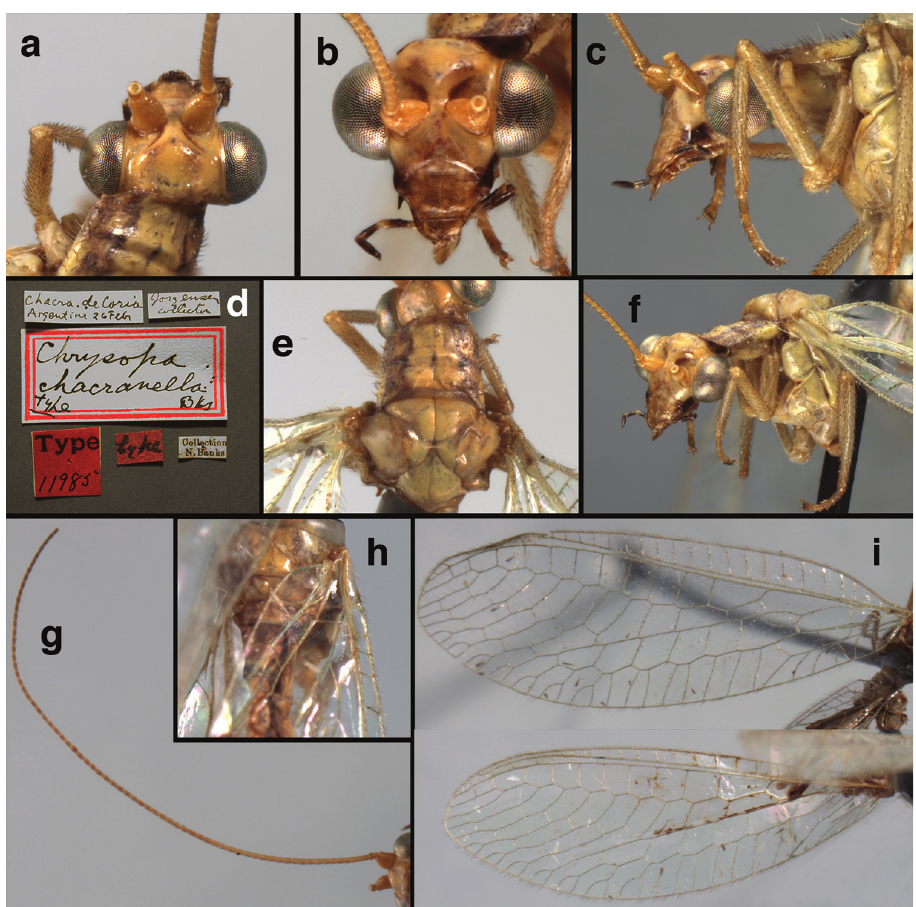
Figure 107. Chrysopa chacranella Banks: Features, ( a ) head, dorsal ( b ) head, frontal ( c ) head, prothorax, lateral ( d ) labels ( e ) prothorax, mesothorax, dorsal ( f ) head, thorax, frontolateral ( g ) antenna ( h ) meta- thorax, dorsal ( i ) wings (Mendoza, Chacras de Coria, holotype, female,